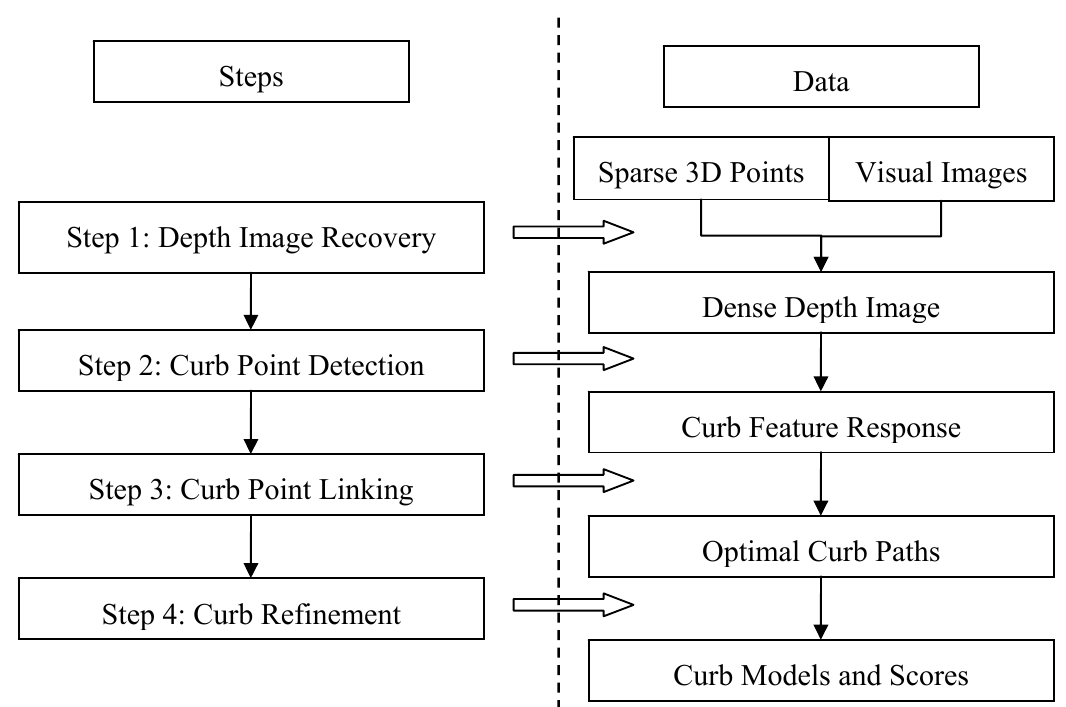
Figure 3. Overview of our proposed method. The method consists of four steps. For more details, please refer to the